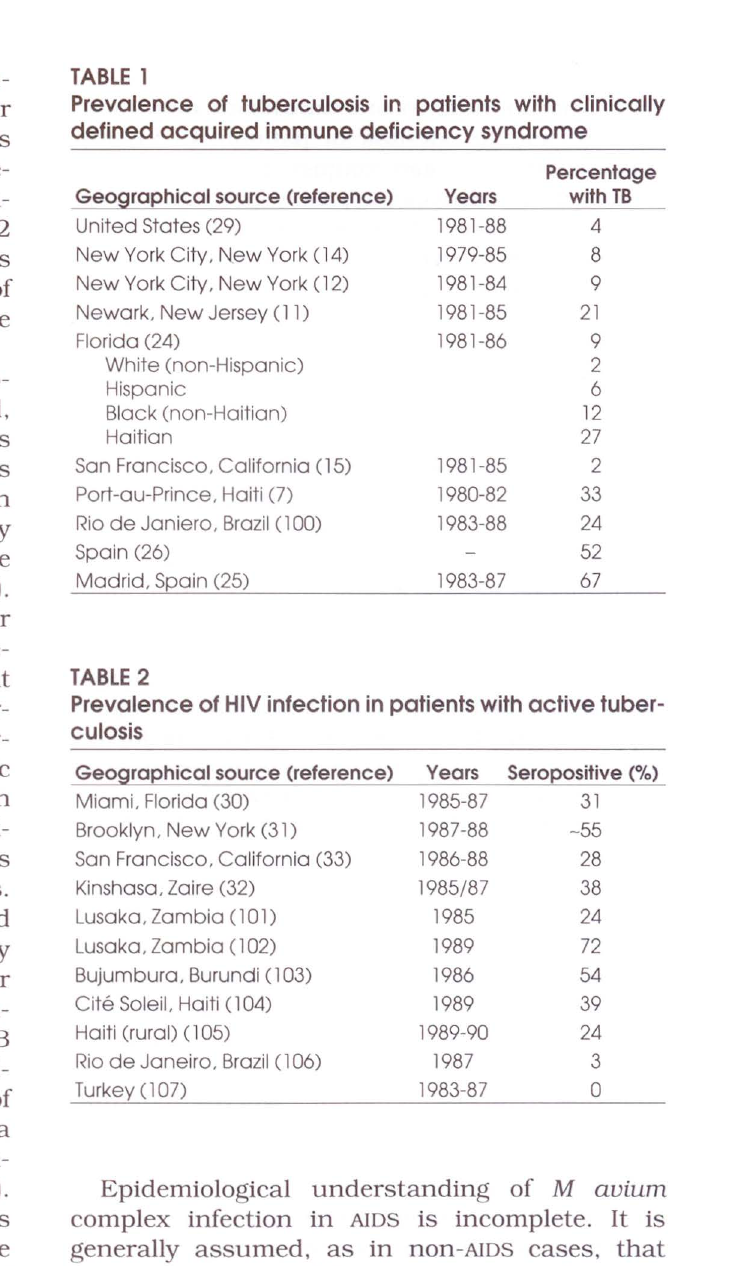
Prevalence of tuberculosis in patients with clinically defined acquired immune deficiency